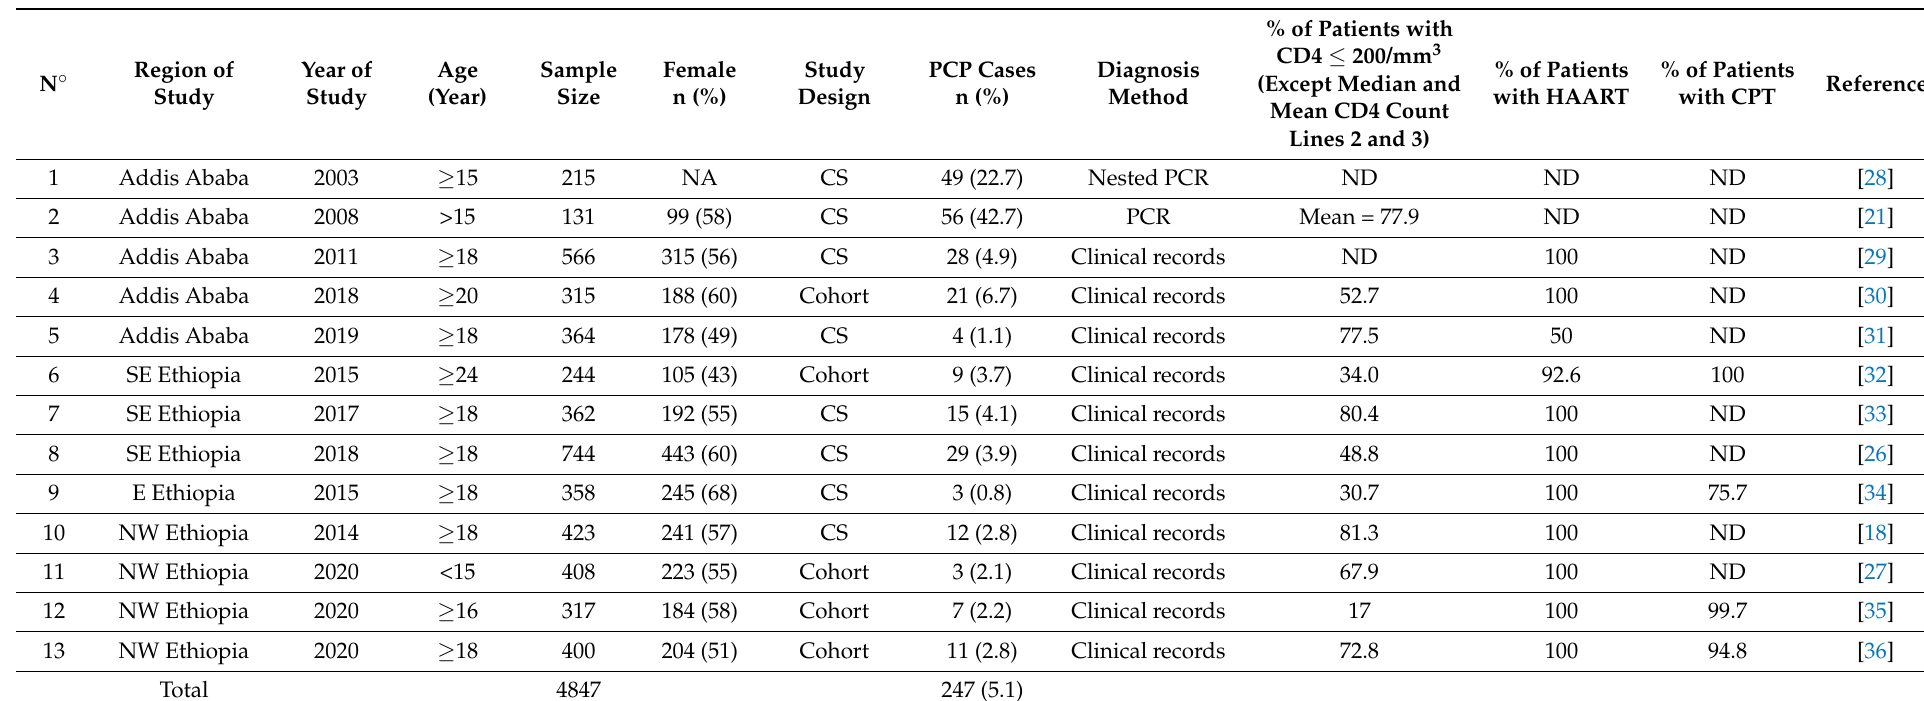
Table 1. Characteristics of the 13 studies included in the systematic review and meta-analysis to estimate the prevalence of Pneumocystis pneumonia in Ethiopia among HIV-infected